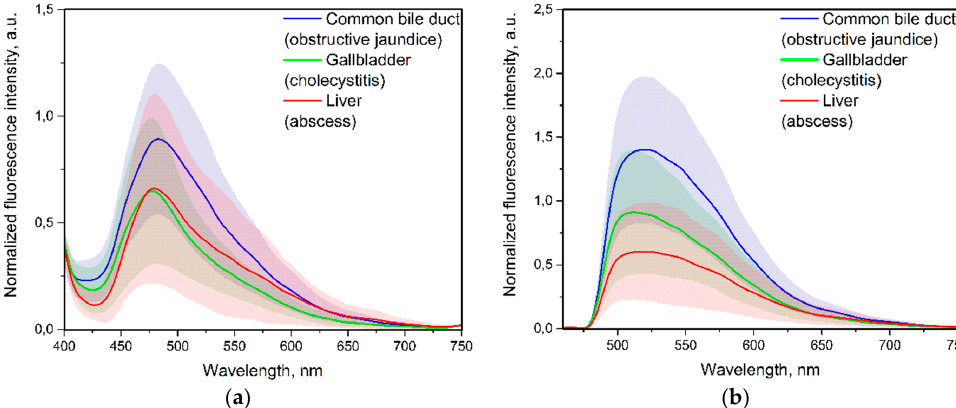
Figure 2. Averaged normalized fluorescence spectra under excitation wavelengths 365 nm ( a ) and 450 nm ( b ). 450 nm ( b